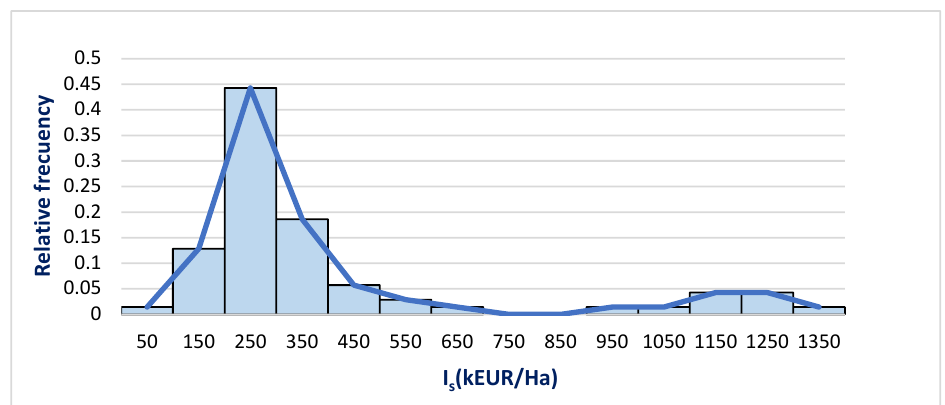
Figure 5. Histogram of the index D E . Once the indicators related to the density of energy production and installed power were analyzed, the indicators related to the economic investment necessary for the design, development and implementation of the PV plants under study in this work were analyzed. In this way, firstly, the indicator I S . (kEUR/Ha) represents the investment density and is defined as the quotient between the global budget (kEUR) and the area of land occupied by the PV plant (Ha). The histogram of I S . (Figure 6) shows that there is great variability in terms of investment density, although 75.69% of the installations have required an economic investment of between 100 and 400 kEUR/Ha. Only in the case of one facility (1.42%) is the investment less than 100 kEUR/Ha compared to 12.85% of facilities for which investment levels reach the highest values of the indicator (900 and 1400 kEUR/Ha).